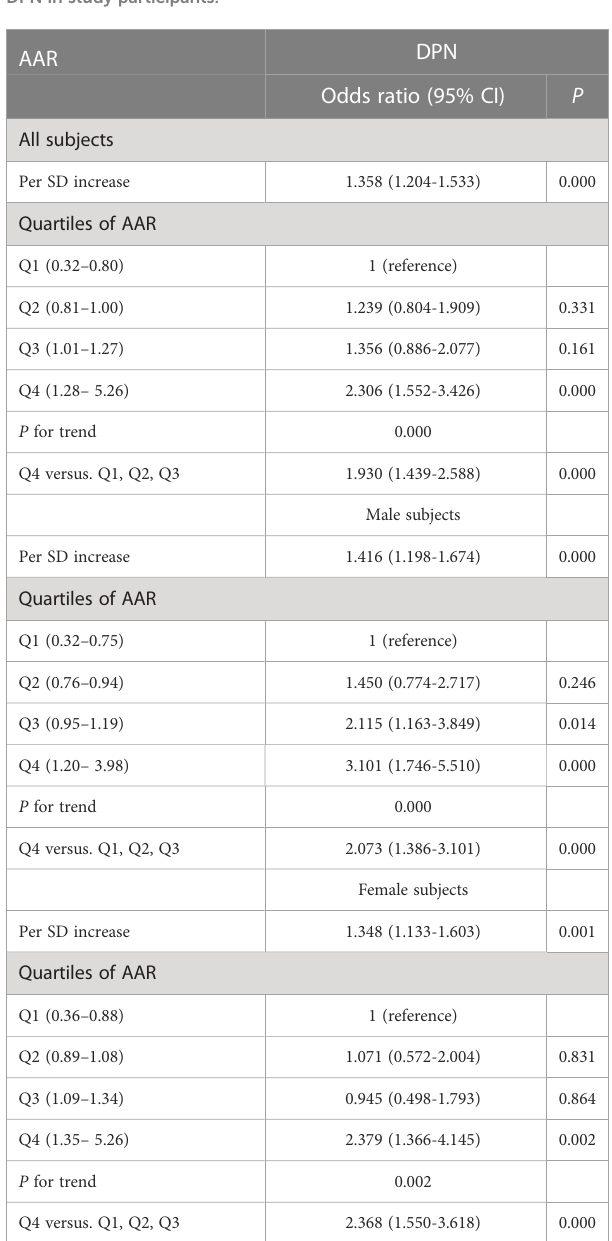
TABLE 4 Association between quartiles of AAR and risk of presence of DPN in study